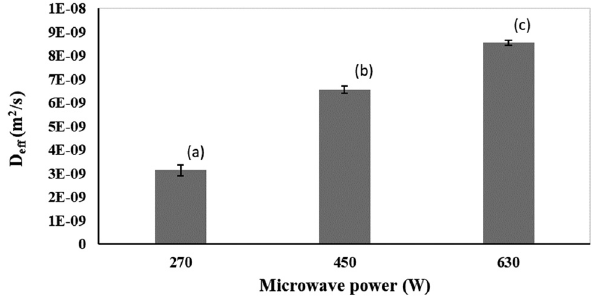
Figure 5: Variation in D eff for the drying of pomegranate arils at di ff erent MW powers. The bars represent mean values and the cor - responding standard deviations. Bars with the same letter are not signi fi cantly di ff erent according to ANOVA and Tukey test ( p < 0.05 ) .